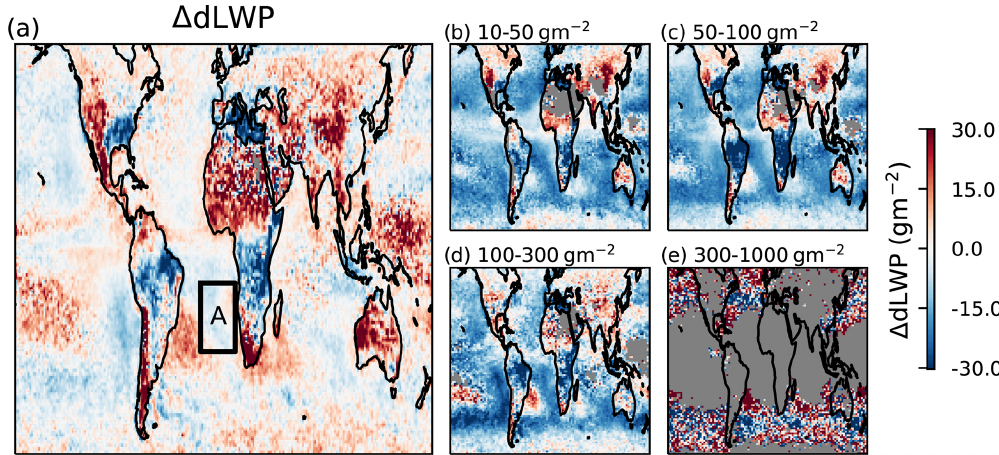
Figure 2. The difference in dLWP between high and low initial N d populations ( (cid:49) dLWP). Red indicates a more positive dLWP for the high N d population ( N d > 60cm − 3 ). Panel (a) includes all available data, and panels (b–e) only consider cases where the initial LWP is within the specified bounds.